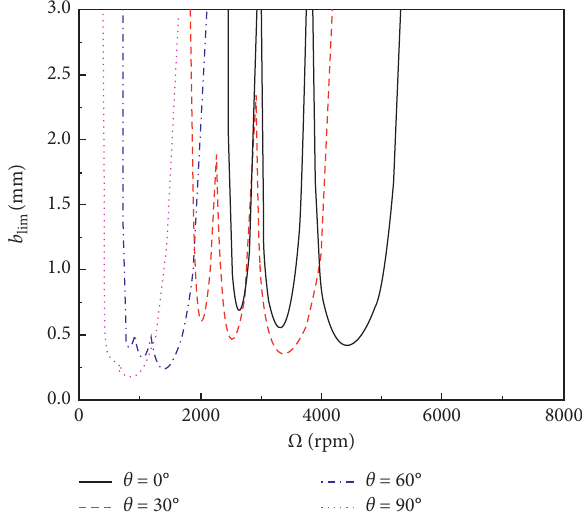
Figure 9: Effect of ply angle on stability lobes of the carbon/epoxy cutter